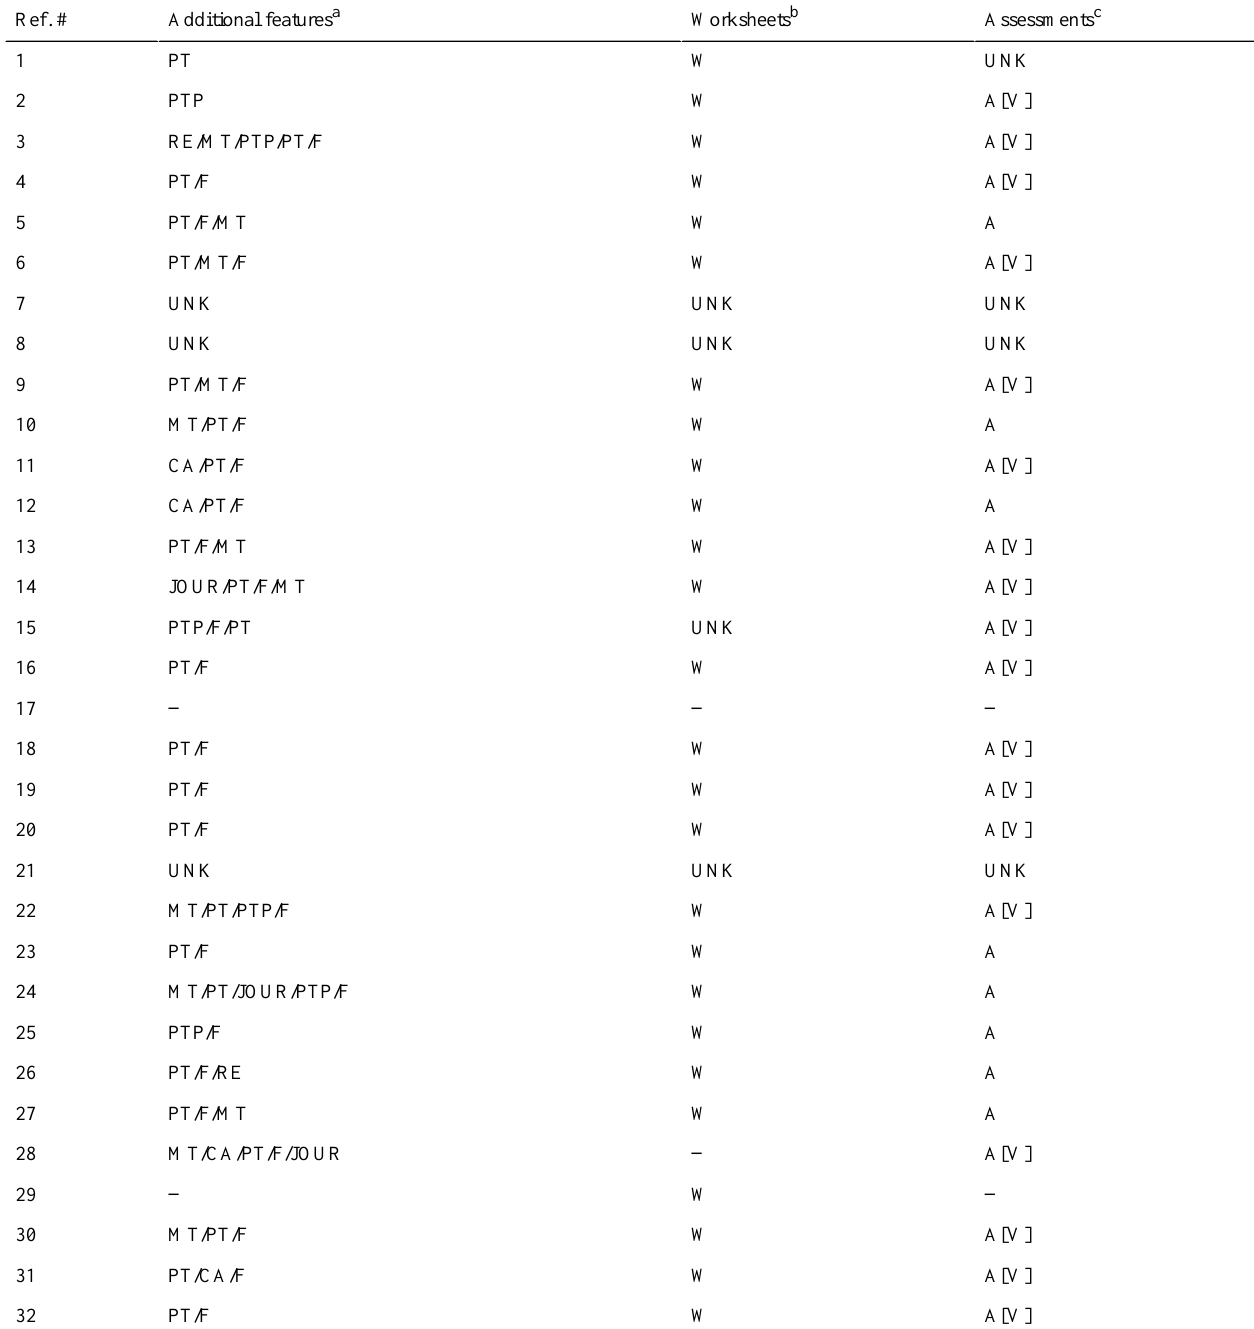
Table 4. Tools associated with the programs